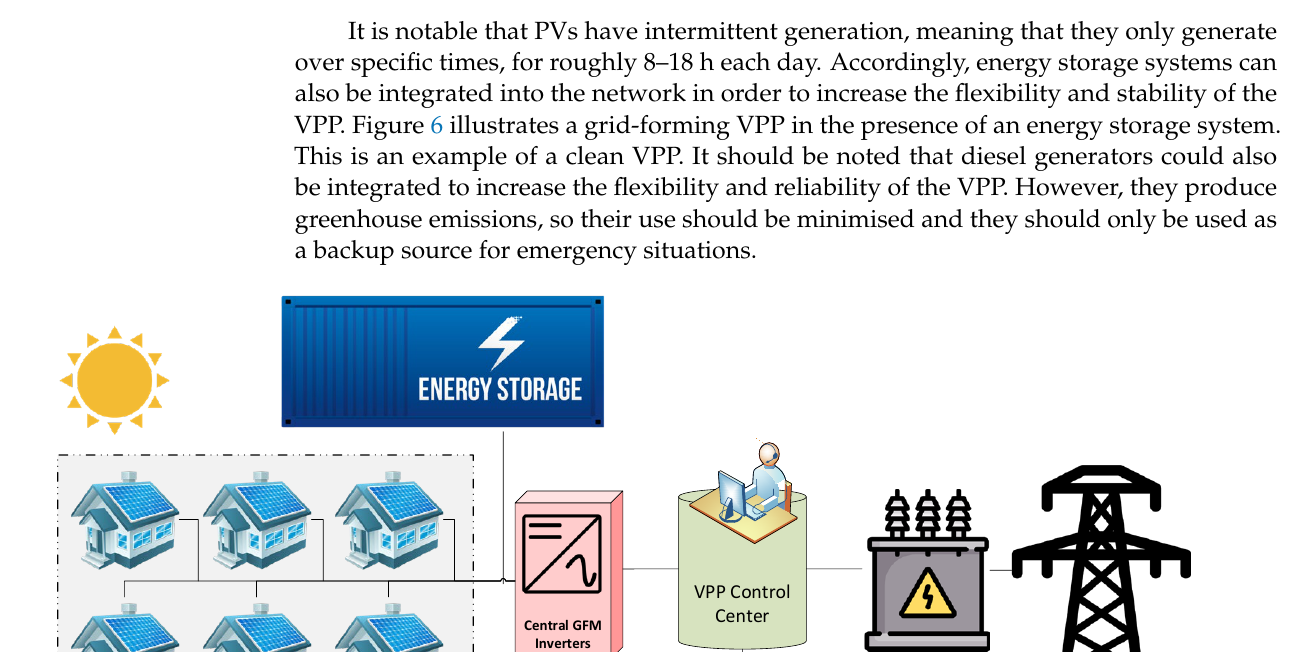
Figure 5. Schematic of a grid-forming VPP without energy storage.